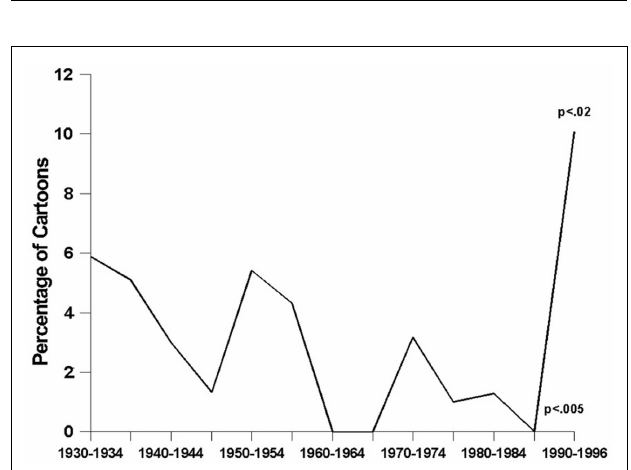
FIGURE 2 |The prevalence of alcohol-related